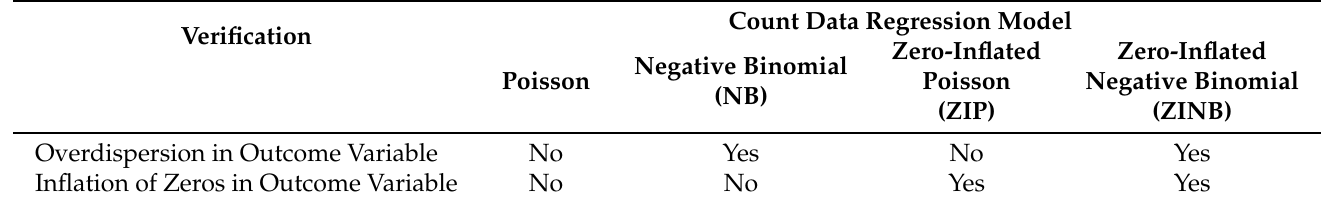
Table 3. Count data regression models, overdispersion, and inflation of zeros in the outcome variable. Verification